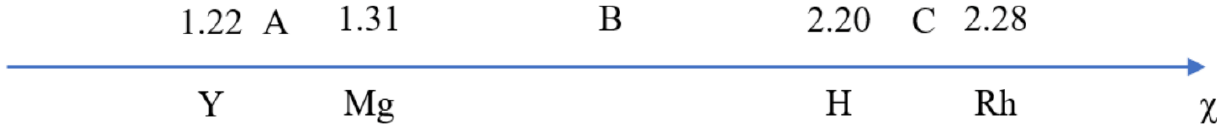
Figure 16. Electronegativity (Pauling scale) of